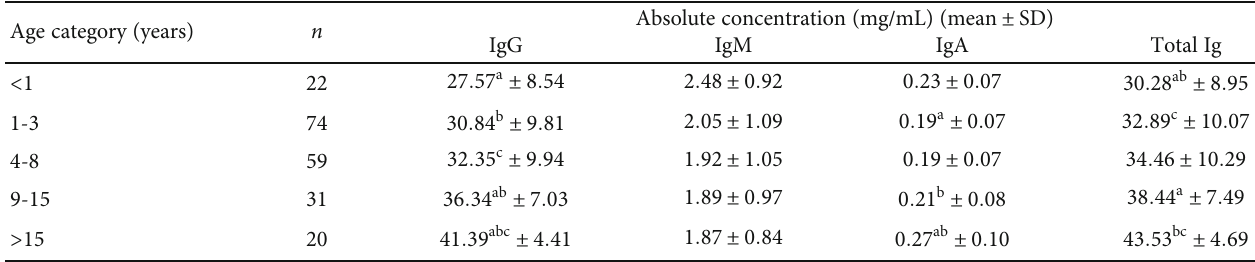
Table 2: Mean ( ± ) absolute concentration (mg/mL) of IgG, IgM, and IgA and total concentration of analyzed Ig (total Ig) in serum of apparently healthy European bison of various ages.